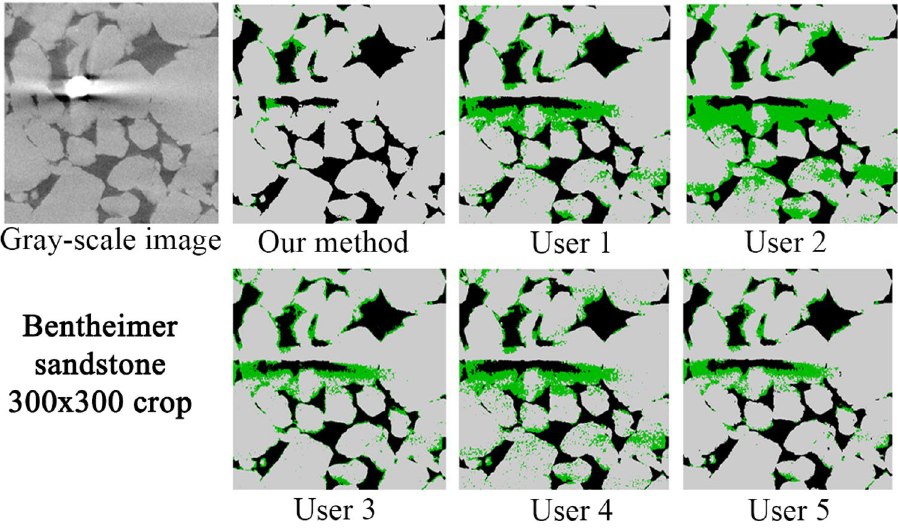
Figure 11. Comparison of segmentation results on a small crop of the Bentheimer image that was heavily affected by beam